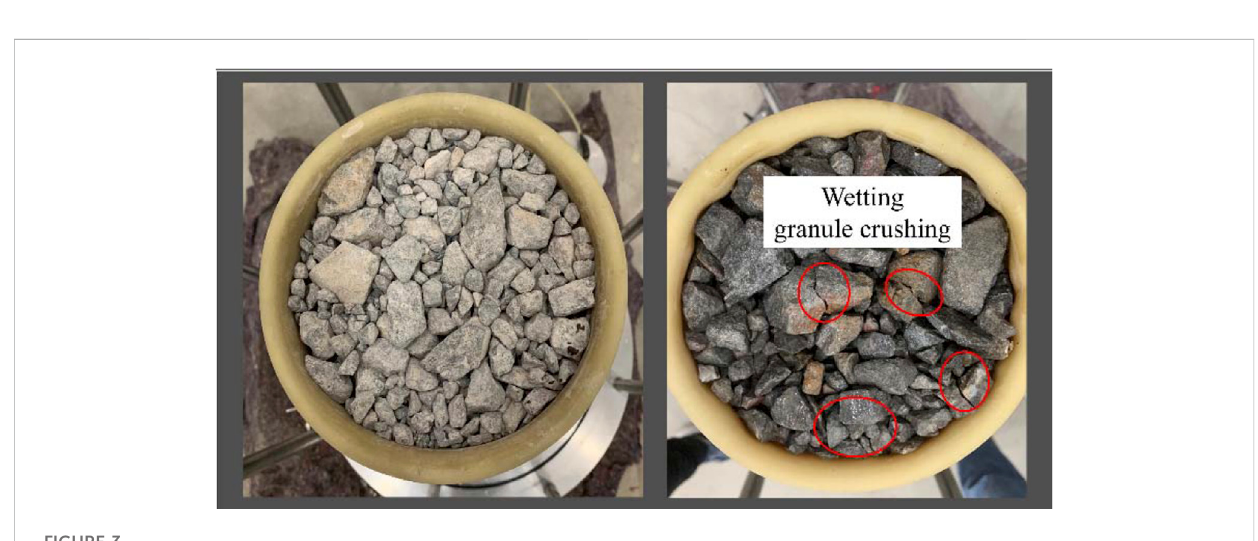
FIGURE 3 Comparison of coarse-grained materials in the dry state and saturated